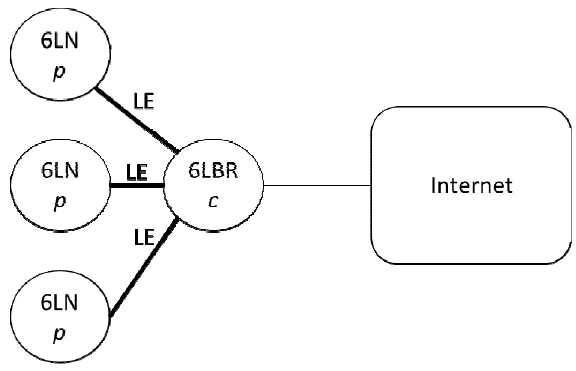
Figure 13. The topology of Bluetooth LE Pico net with roles.